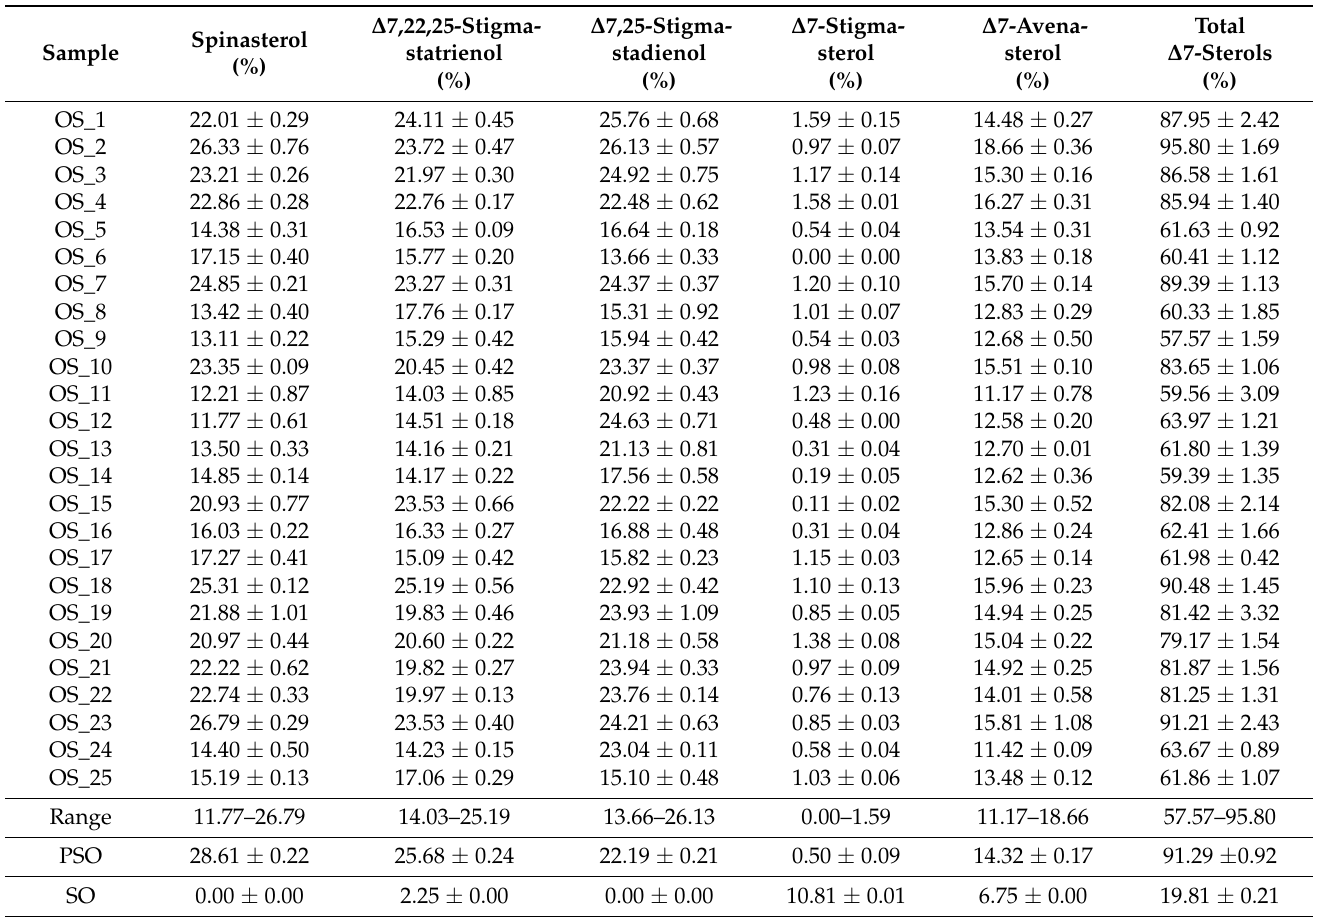
Table 2. ∆ 7-sterols (mean ± standard deviation, n = 3) in analysed oil samples (PSO_1–25—samples labelled as pumpkin seed oils obtained from the market, PSO—pumpkin seed oil produced in a laboratory, SO—sunflower